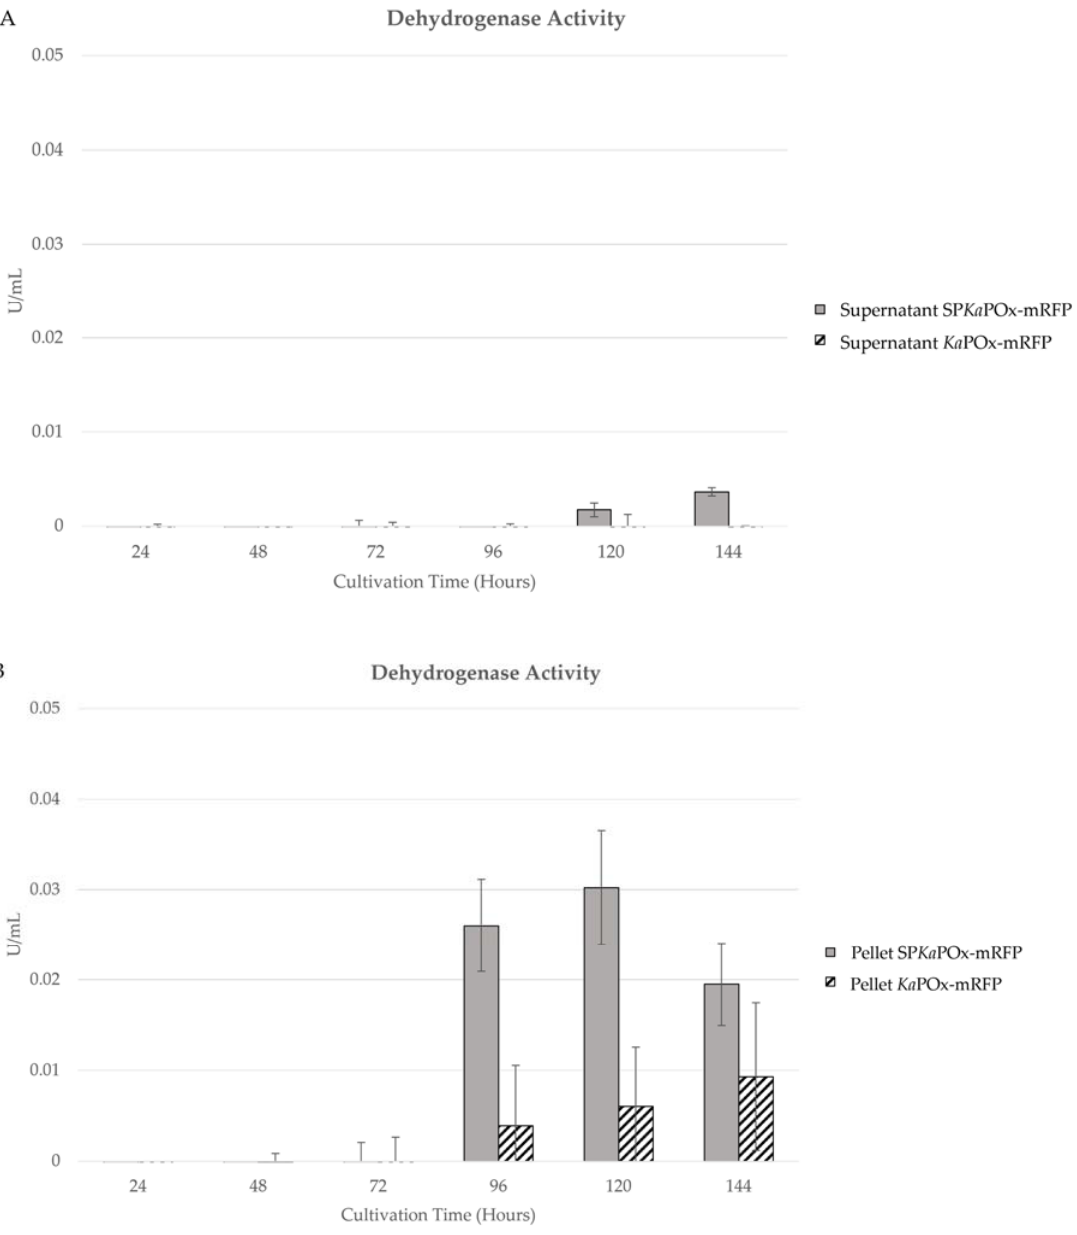
Figure 6. Enzymatic activity (dehydrogenase) in samples of the supernatant ( A ) and the pellet fractions ( B ) of cultures harboring SP Ka POxmRFPHis and Ka POxmRFPHis. Activity values are normalized for the recorded wet cell weight, as in Figure